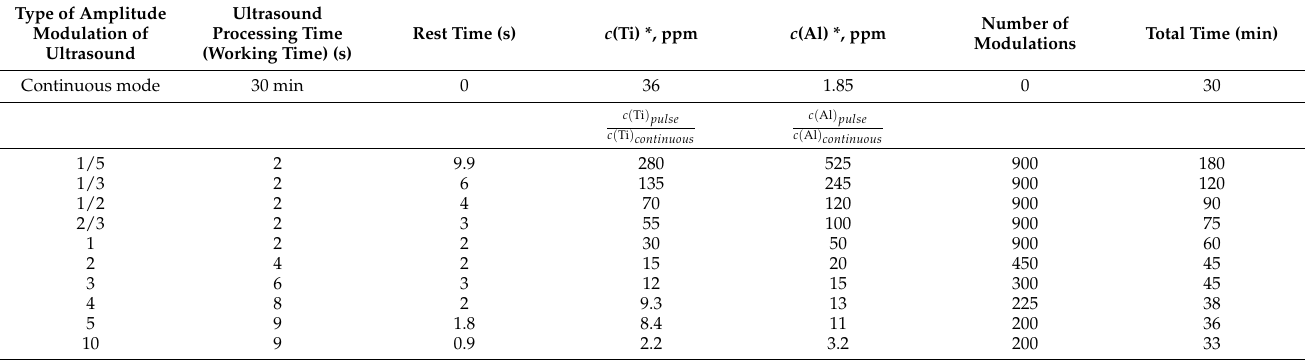
Table 2. Titanium and aluminum content during ultrasonic modulations estimated by ICP–AES.